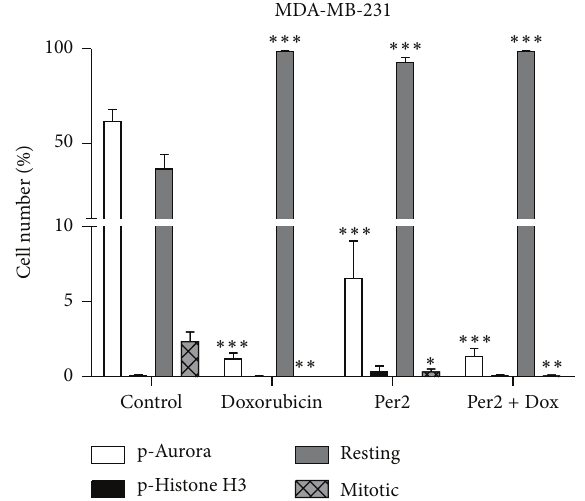
Figure 6: Determination of G2/M cell cycle transition in MDA- MB-231 breast cancer cells following Per2 silencing and doxorubicin treatment. MDA-MB-231 cells were subjected to (1) control condi- tions (C), (2) 2.5 𝜇 M doxorubicin (D), (3) 30 nM Per2 esiRNA (P), and (4) 30 nM Per2 for 48 hours + 2.5 𝜇 M doxorubicin for 24 hours (PD). G2/M transition analysis was assessed by flow cytometry. Statistical analysis: one way ANOVA with Bonferroni post hoc correction. All results are presented as mean ± SEM ( 𝑛 = 3 ). ∗ = 𝑃 < 0.05 versus control, ∗∗ = 𝑃 < 0.001 versus control, and ∗ ∗ ∗ = 𝑃 < 0.0001 versus